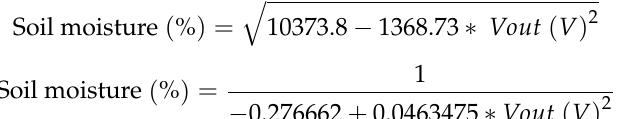
Table 10. Values of R2 and REs in NP2 (II) using two models.